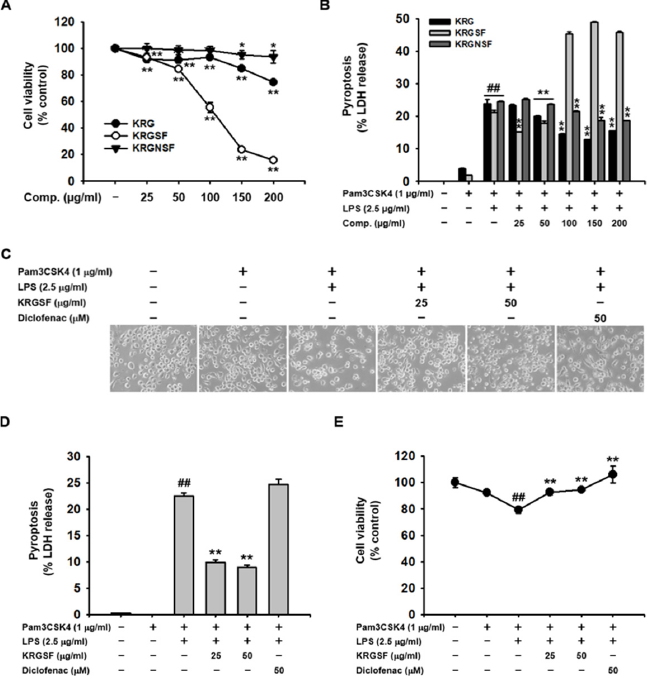
Figure 1. Suppressive role of KRGSF on caspase-11 non-canonical inflammasome-activated pyroptosis in J774A.1 cells. ( A ) J774A.1 cells were treated with the indicated doses of KRG, KRGSF, and